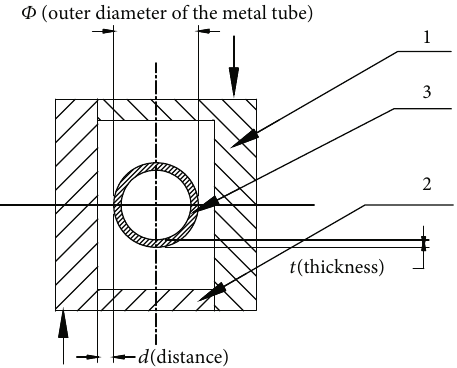
Figure 1: Compression model for a hollow metal tube.